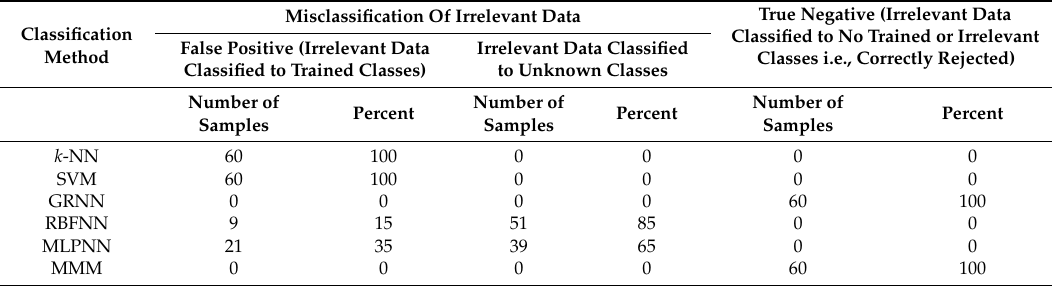
Table 5. Classification performance of the algorithms with 60 irrelevant data samples (i.e., data from mango ripening stages). In the table k -NN, SVM, GRNN, RBFNN, MLPNN, and MMM are abbreaviated forms of k -nearest neighbor, support vector machine, generalized regression neural network, radial basis function neural network, multilayer perceptron neural network, and minimum-maximum-mean,